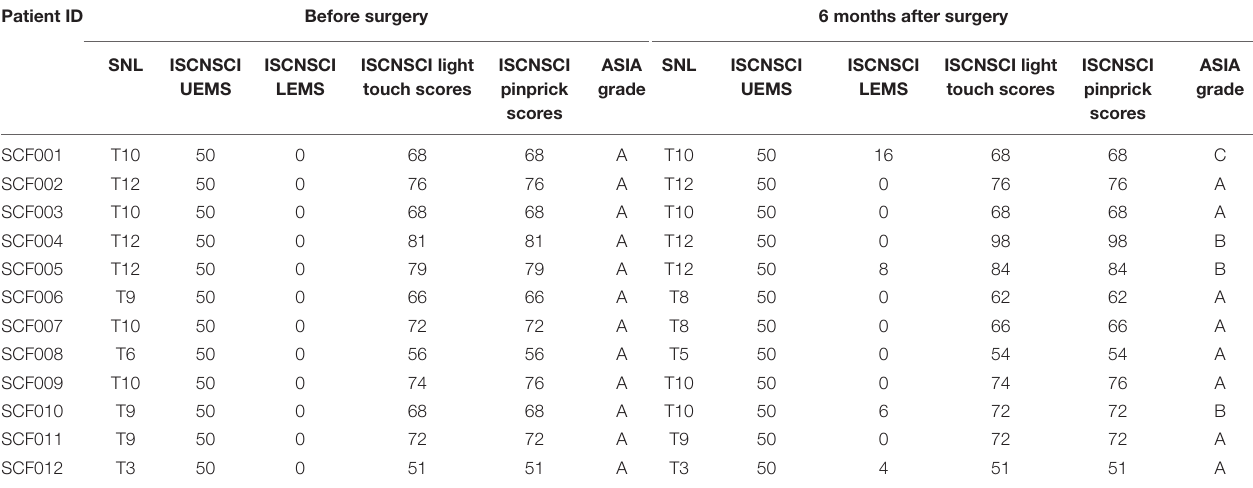
TABLE 5 | Sensory and motor function assessments according to the International Standards for Neurological Classification of Spinal Cord Injury. Patient